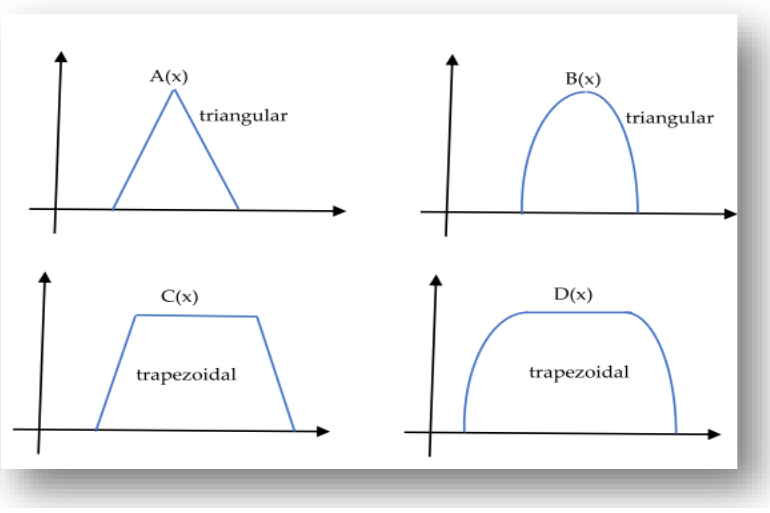
Figure 2. Basic types of fuzzy Figure 2 . Basic types of fuzzy numbers .